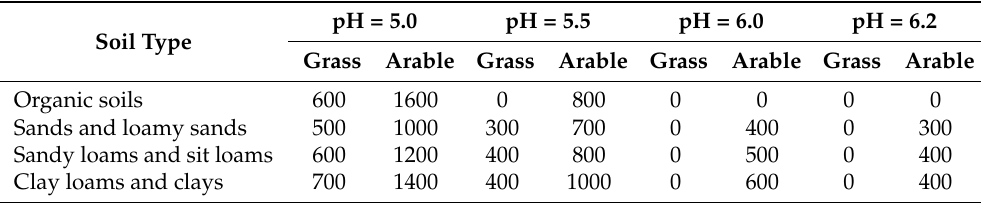
Table 4. Quicklime (CaO) required (g m − 2 ) depending on the soil type and initial pH.